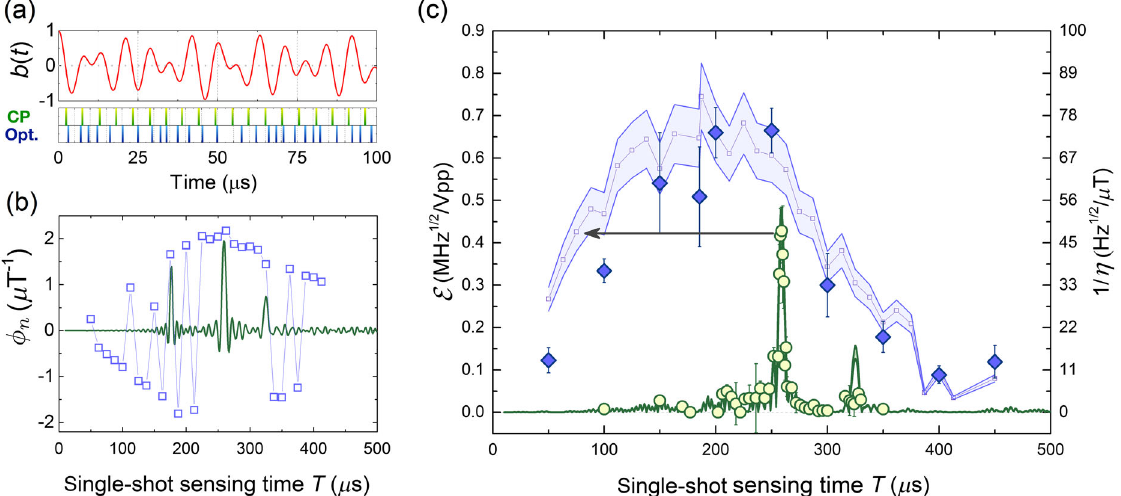
P 3 w 2 πν t þ α FIG. 3. Optimized sensing of multitone ac fields. (a) Upper panel: Sample multitone target field, b ð t Þ ¼ b i cos ð i i Þ , with i α 0 , frequencies ν 77; 96; 141 Þ kHz, and amplitudes w 0 . 12; 0 . 43; 0 . 45 Þ , respectively. Bottom panel: In green, position of i ¼ i ¼ ð i ¼ ð the first 19 π pulses of a Carr-Purcell sequence of 50 equidistant π pulses (CP- 50 ) with optimized sensing time ( T ¼ 260 μ s); in blue, position of the first 27 π pulses of an optimal control sequence of 50 non-equally-distributed π pulses with optimized time intervals and optimized initial phase ( T ¼ 187 μ s, α i ¼ 0 . 3 ). (b) Phase ϕ n ð T Þ ¼ φ n ð T Þ =b accumulated by the spin qubit sensor during the sensing time T in the presence of the field b ð t Þ , under a control field of n ¼ 50 π pulses, in the cases of CP- 50 (solid line) and optimized control (blue squares). (c) Experimentally measured E ¼ C= η in the presence of the field b ð t Þ under CP- 50 (dots) and optimized control (diamonds). The curves represent the theoretical prediction for E , for CP- 50 (solid green line) and optimized control (blue line), respectively, obtained by rescaling 1 = η (right-hand side, vertical scale) with the unique factor C . The shaded area takes into account the experimental uncertainty due to C (see Appendix A